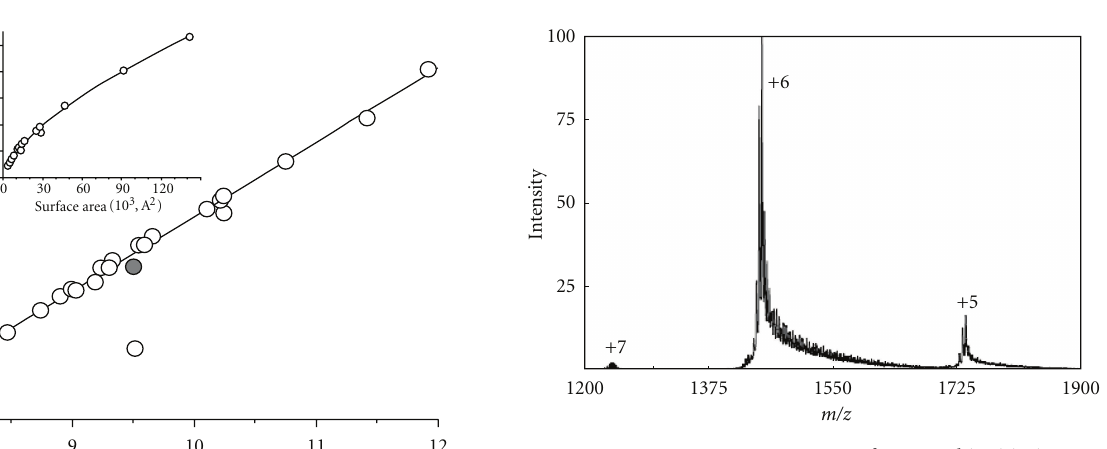
Figure 13: Nano-ESI-mass spectrum of 25 μ M ubiquitin in 1mM NaCl solution. The spectrum was obtained at low nozzle-skimmer potential, so that there was little collisional activation of the